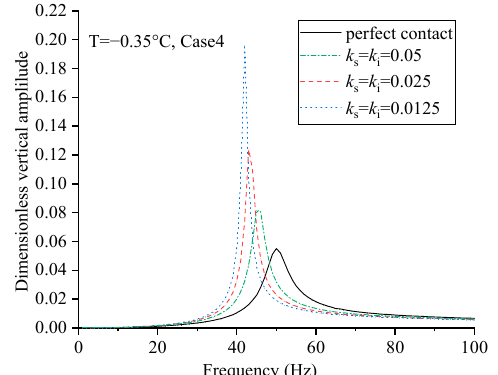
Figure 9. Effects of k s and k i on the amplitude–frequency curves of the pile foundations.